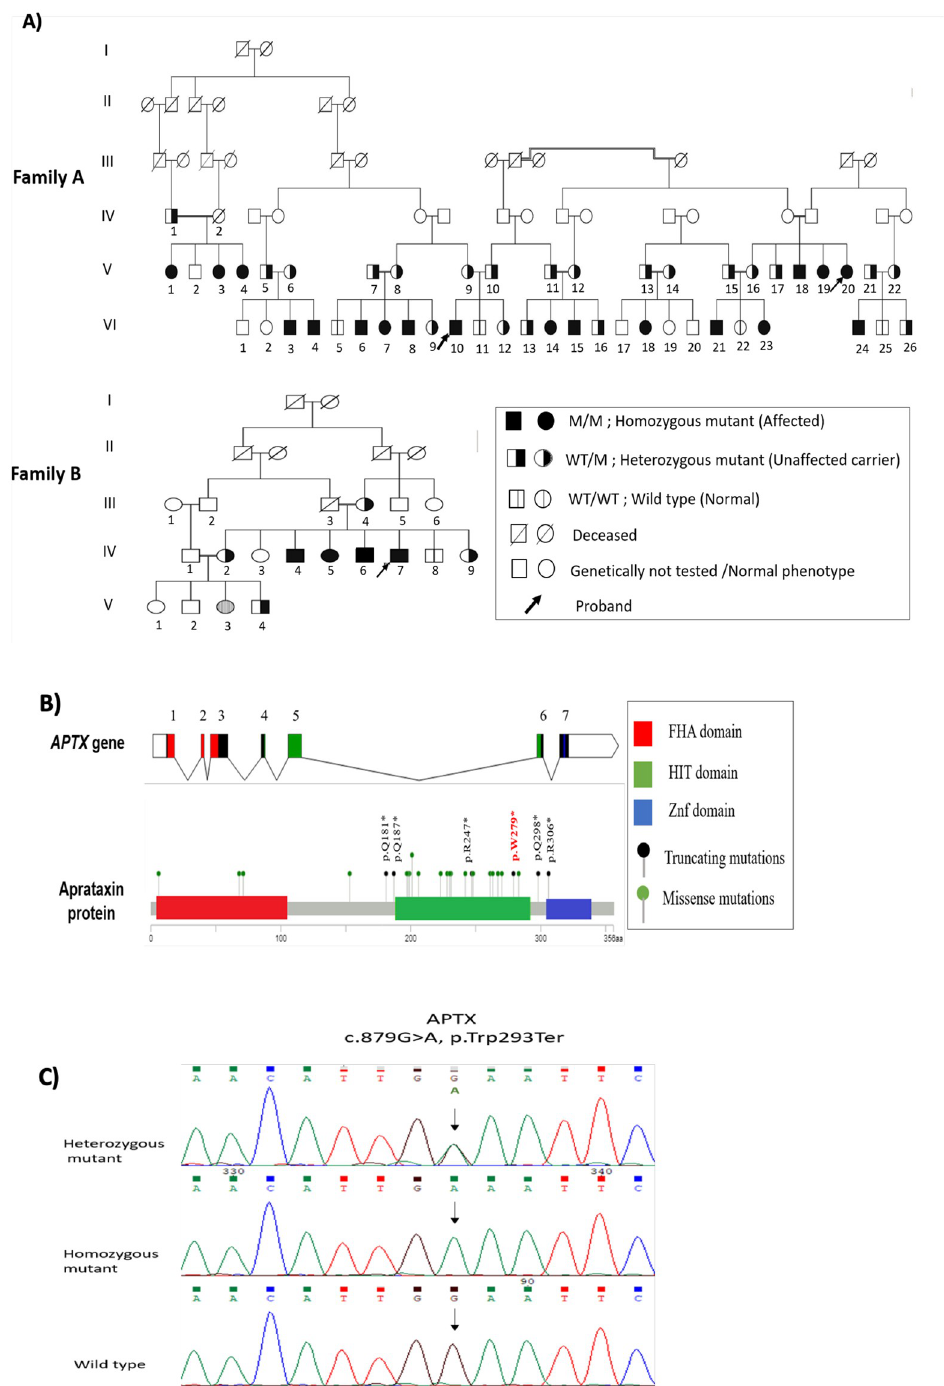
Fig 1. Identification of disease-causing mutation and segregation analysis. A) Pedigrees of two unrelated families with AOA1 disease, carrying APTX nonsense truncating mutation (c.837G > A; p.W279 � ). B) The location of p.W279 � in the APTX gene occurs in the histidine triad (HIT) domain of the aprataxin protein. C) Sanger sequencing of the identified truncating mutation on exon 6 of the APTX gene, which occurs as homozygous mutant p.W279 � APTX gene mutation. The other sequences represent heterozygous mutant (A/G) or wild-type (A/A).